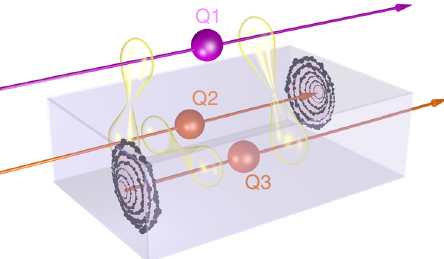
Fig. 1 Open timelike curve circuit (pictorial representation). Qubits Q1 and Q2 are initially in a singlet state. Qubit Q2 enters a chronology-violating region, emerging as qubit Q3. In the chronology-violating region, qubits Q1 and Q2 must be in a singlet state, and so are qubits Q1 and Q3. Furthermore, since Q2 and Q3 are, respectively, the past and future copy of the same qubit, they are maximally correlated. This situation